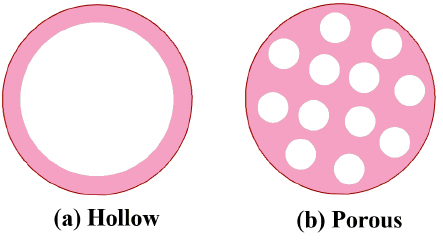
Figure 3. Schemes of the hollow ( a ) or porous ( b ) ceramic proppant.